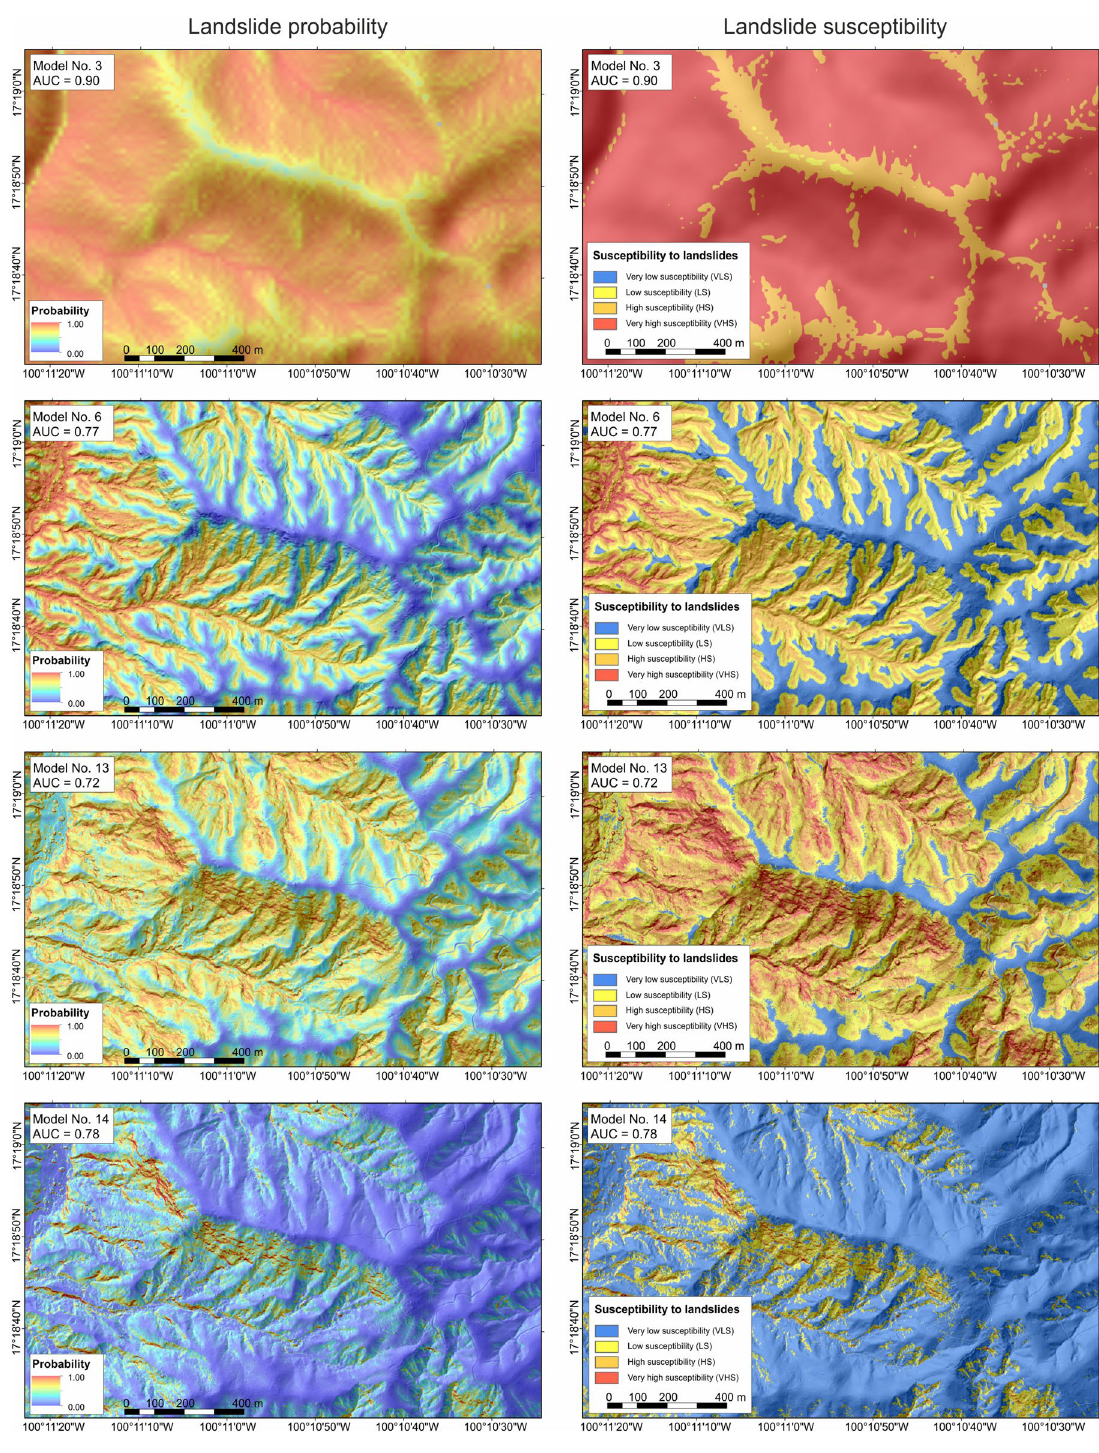
Figure 7. Comparison of selected landslide probability and susceptibility models produced for region No 1. Maps were generated using ArcMap 10.2.2 software, copyright and licensed by ESRI (http:// deskt op. arcgis. com/ en/). The final layout was created in ArcMap 10.2.2 (http:// deskt op. arcgis. com/ en/) and CorelDRAW 2018 (https:// www. corel draw. com/